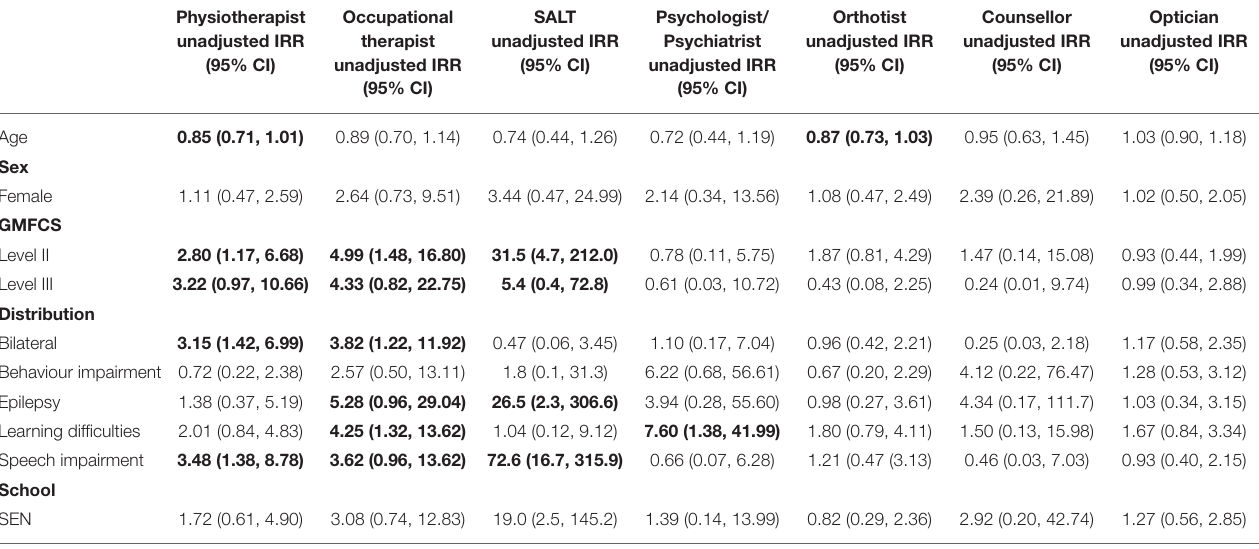
TABLE 6 | Unadjusted associations with number of visits to a physiotherapist, occupational therapist, speech and language therapist, psychologist/psychiatrist, orthotist, counsellor, optician. Physiotherapist unadjusted